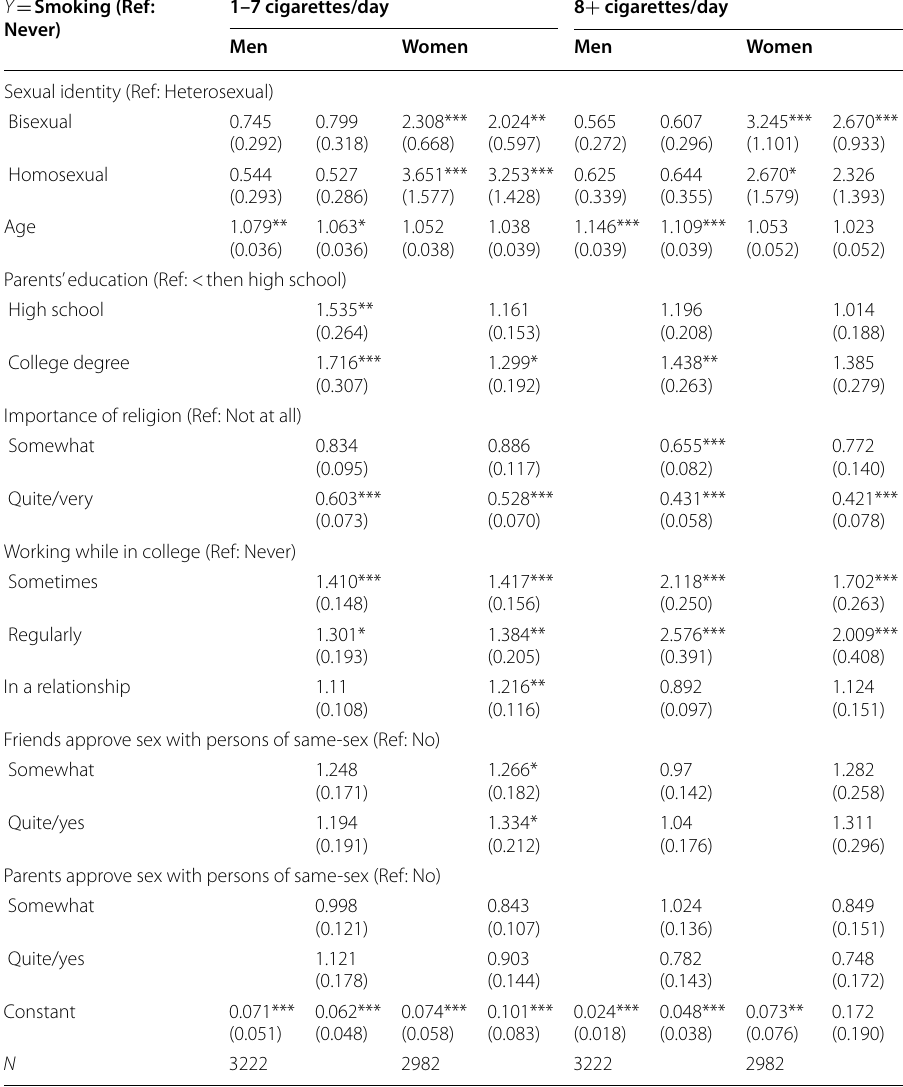
Table 2 Multinomial logistic regression,